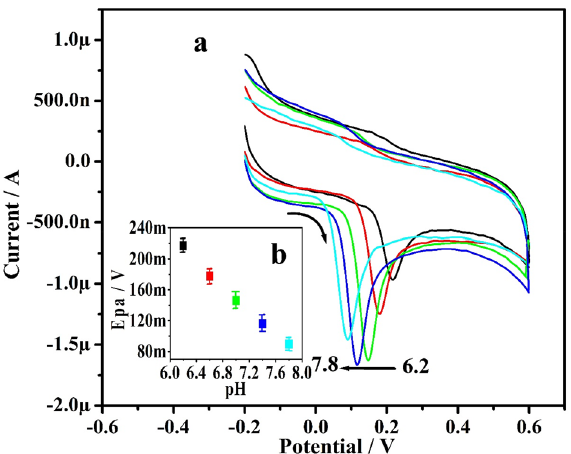
Figure 6. ( a ) CVs for ADR with pH series at Po-ERY/MGPE. ( b ) Graph of Epa Vs altered pH for